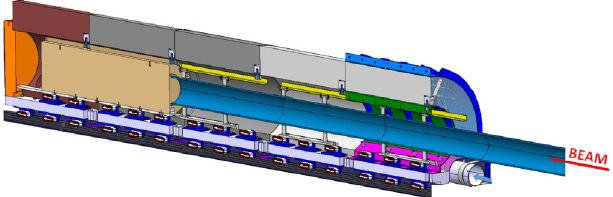
FIG. 5. CAD Section view of the new dump core-shielding assembly, showing the CuCr1Zr dump core, the cast iron shielding blocks as well as the concrete ones. The ducts for the air cooling and the aluminum alloy beam pipe are also